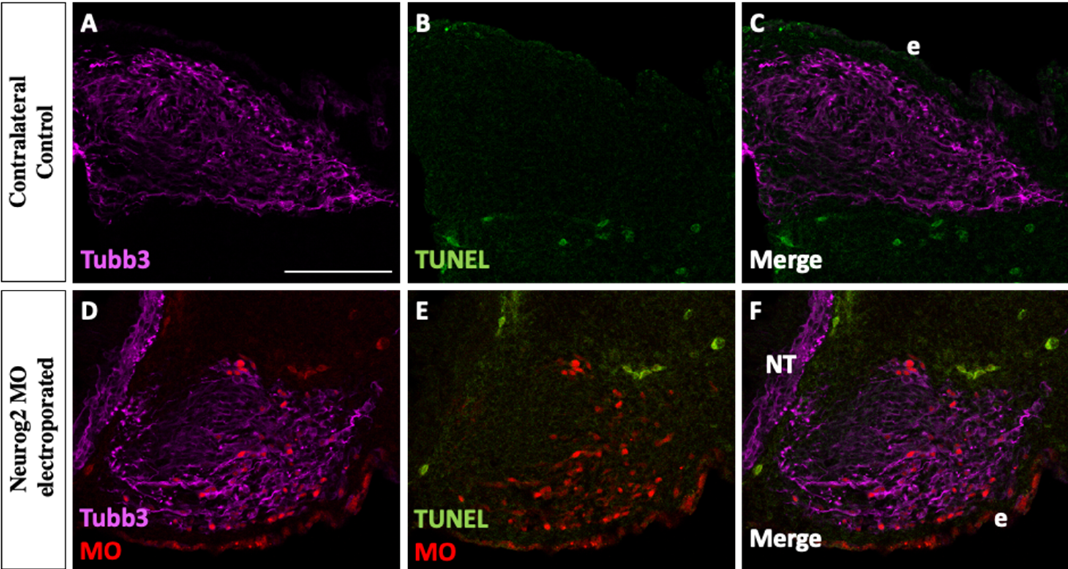
Figure 4. Depletion of Neurog2 in trigeminal placode cells does not cause increased cell death. Representative transverse section through the forming trigeminal ganglion (E3–3.5 (HH19), n = 5) after Neurog2 MO unilateral electroporation ( D – F , red) followed by Tubb3 immunohistochemistry to detect placode cell-derived neurons ( A , C , D , F , purple) and TUNEL staining to identify apoptotic cells ( B , C , E , F , green). Scale bar in ( A ) is 100 µ m and applies to all images. Abbreviations: e, ectoderm and NT, neural tube.